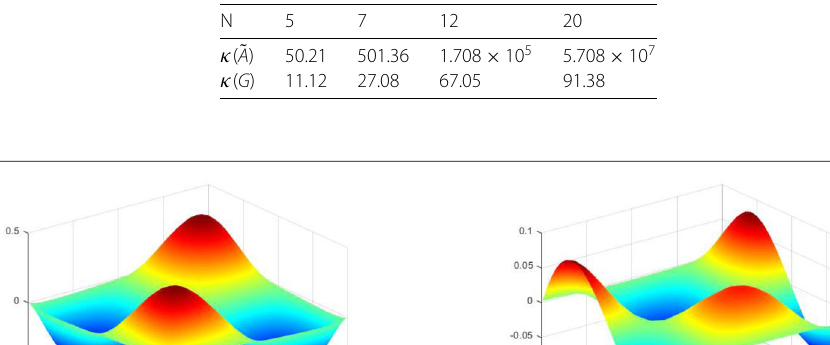
Table 3 The condition number for the matrices of the two algorithms